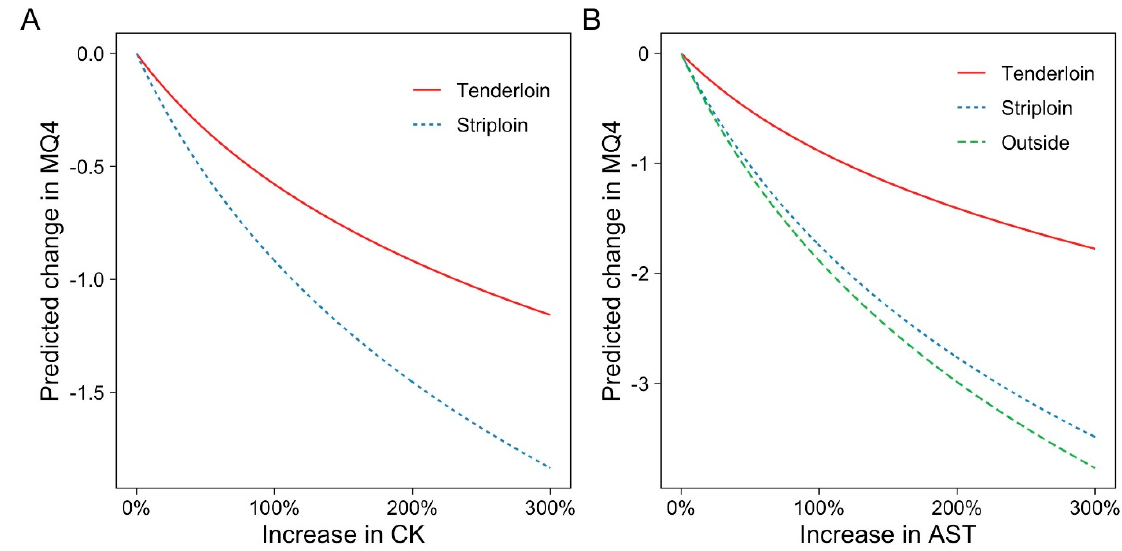
Figure 4. Associations of aspartate aminotransferase (AST) and creatine kinase (CK) with MQ4. Only the coe ffi cients with p -values less than 0.1 are shown.